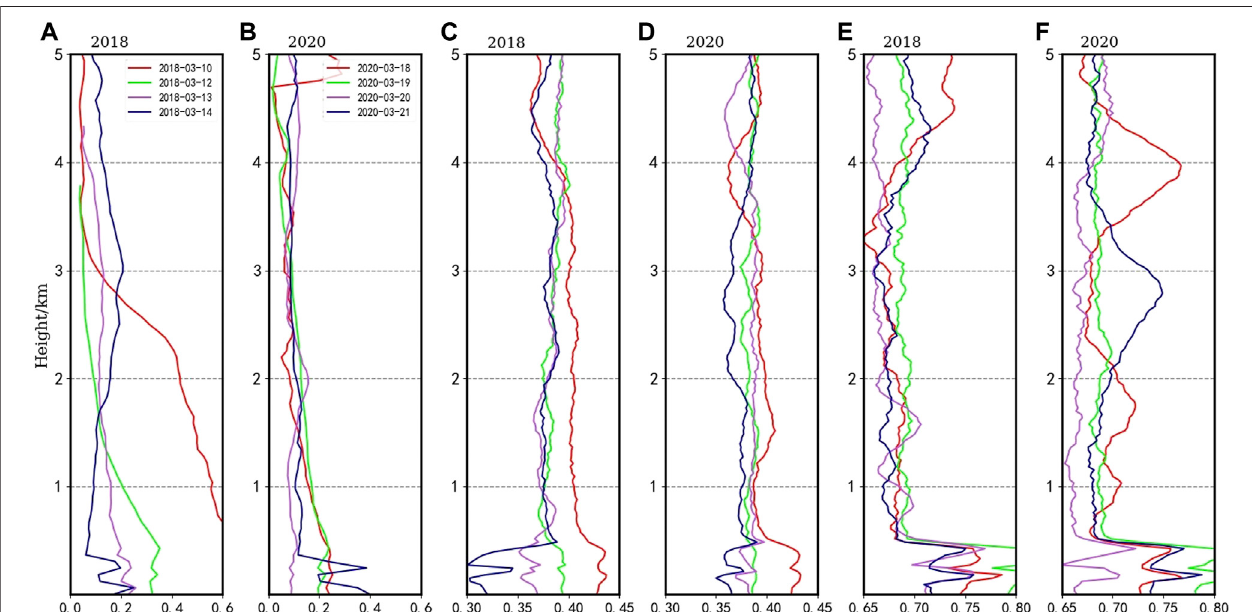
FIGURE 5 | Vertical distributions of the Extinction Coef fi cient [unit:/km, (A,B) ], the 532 nm Particulate Depolarization Ratio (C,D) , and the Color Ratio (E,F) of the aerosols (clean marine, pure dust, polluted continental/smoke, clean continental, polluted dust, elevated smoke) from CALIOP on March 10th, 12th to 14th in 2018 (A,C,E) , March 18th to 21st in 2020 (B,D,F) .